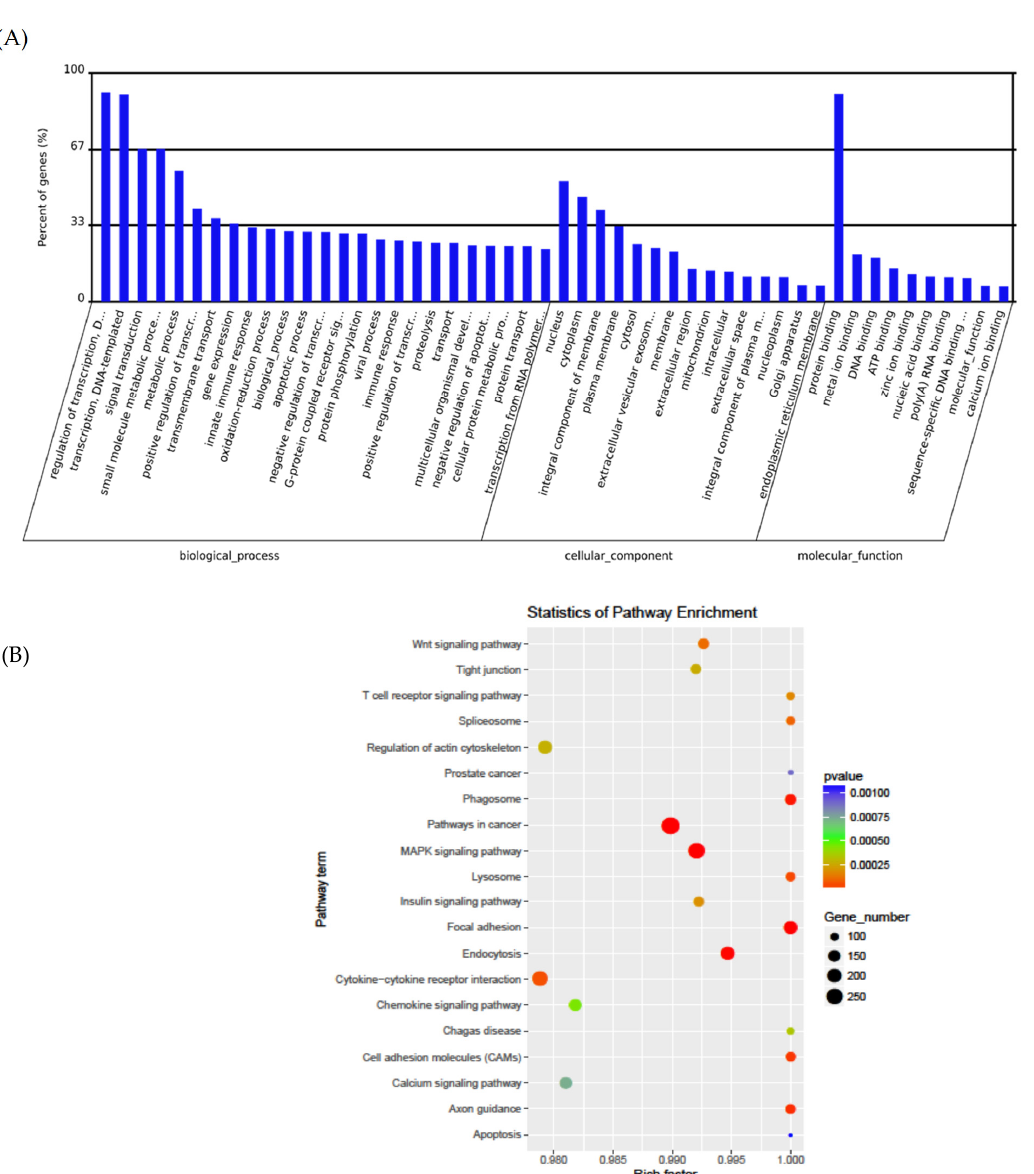
Figure 4. Enrichment analysis of the differentially expressed miRNAs. ( A ) GO function classification of the target genes of differentially expressed miRNAs. The top 25, 15, and 10 GO terms in biological processes, cellular components, and molecular functions, respectively. ( B ) The top 20 enriched KEGG signaling pathways of the target genes of differentially expressed miRNAs.